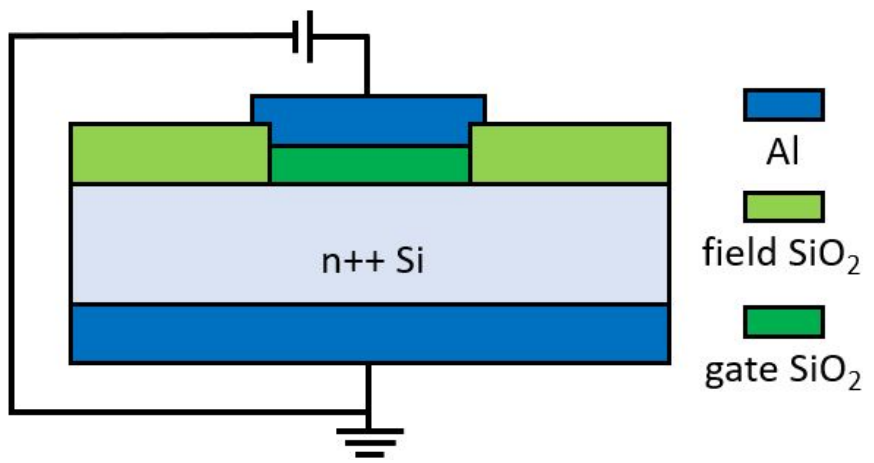
Figure 1. Schematic picture of the measured structure (not to scale).